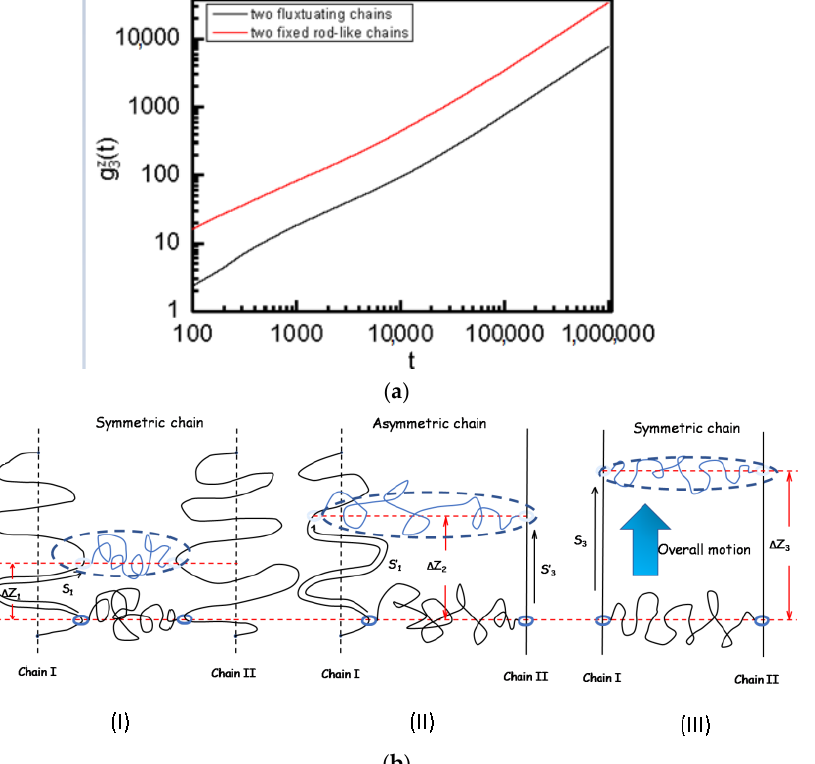
Figure 9. ( a ) The absolute mean-square displacement (MSD), g (cid:2871)(cid:2936) ( t ) , of the ring from the center of mass of the ring in the z -axis direction for ring chain along two symmetric fluctuating axial chains and two symmetric fixed rod-like axial chains. The definition of the z -axis direction is given in Figure 1. ( b ) A schematic illustration to explain why ring chain slide along fixed rod-like axial chain on the asymmetric chain slower than that on the symmetric chain (i.e., S (cid:48) 3 < S 3 ) and why ring chain slide along fluctuating axial chain on the asymmetric chain faster than that on the symmetric chain (S (cid:48) 1 > S 1